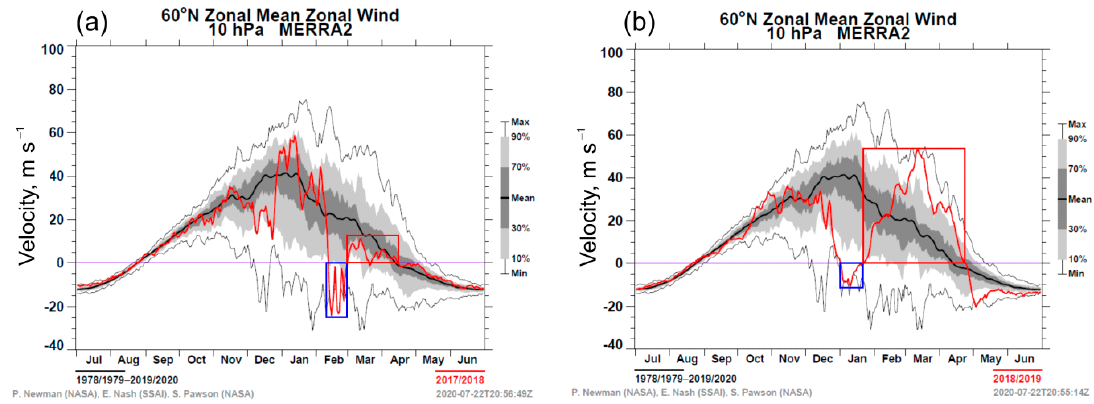
Figure 1. Mean zonal wind during the ( a ) 2018 and ( b ) 2019 sudden stratospheric warming (SSW) events at 60° N, 10 hPa by MERRA-2 data [41]. Note the difference in the easterly and westerly persistence and velocity change in the SSW and post-SSW time intervals (outlined by blue and red rectangles, respectively).